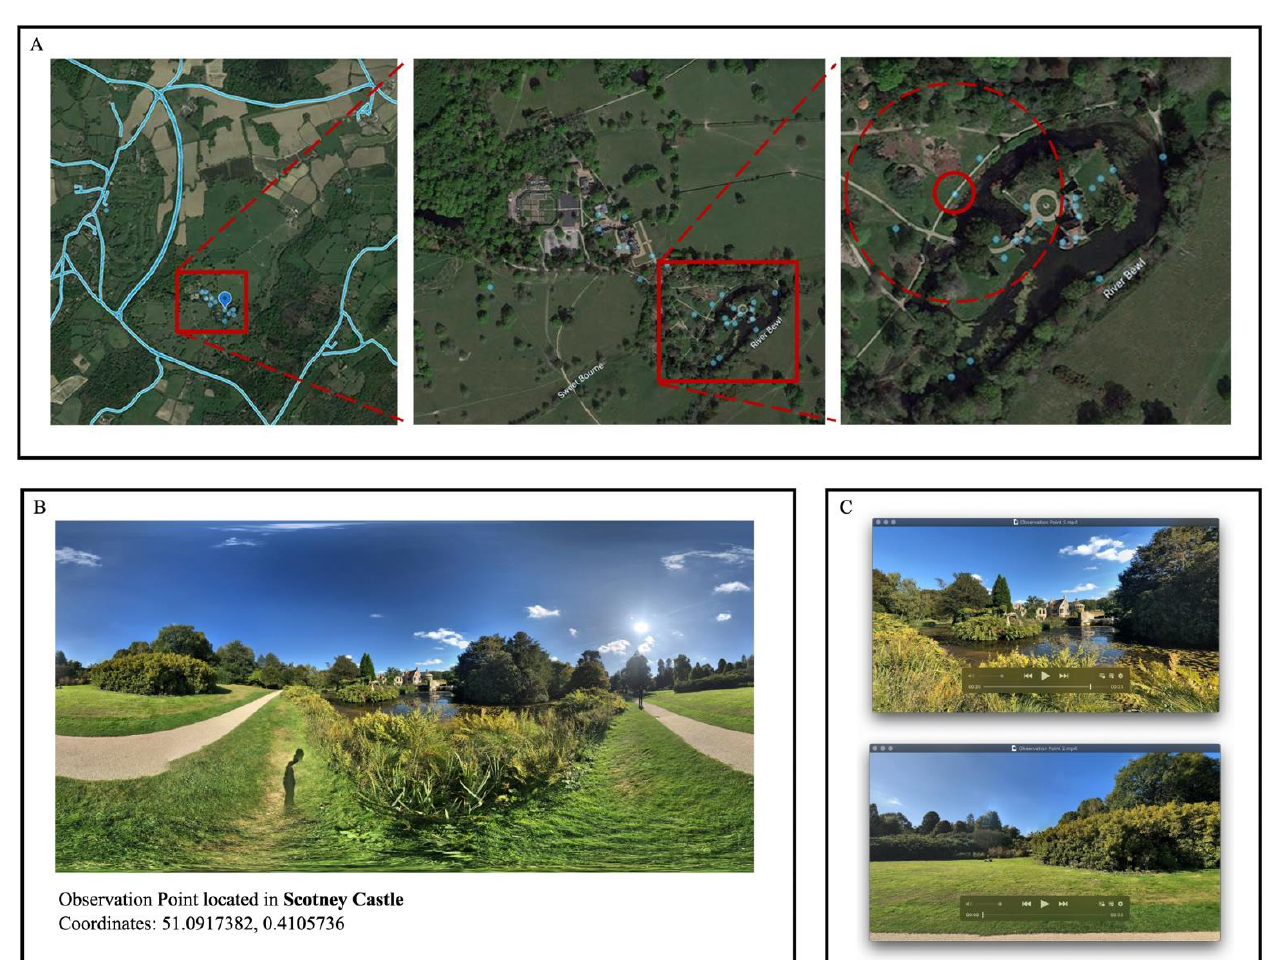
Figure 2. Panoramas from millions of shooting locations are available on the GSV platform. Shooting locations are continuous along the roads, as shown in ( A ), and appear as a blue line, whereas they are mainly dispersed in the off-road area, where they appear as blue dots. ( B ) Use the Street View Download 360 Pro (version 3.1.3) program to download a specific panorama. ( C ) Create a panoramic video clip using the specified parameters after converting the panorama. Take C15 as an illustration.